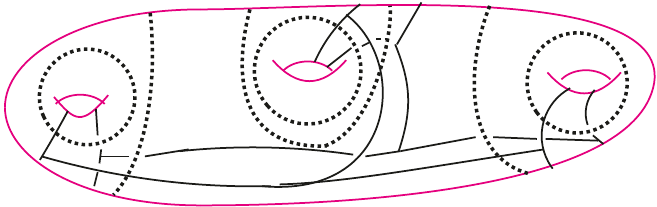
Figure 1 . A basis for a genus 3 surface. Three of the shown vacuum loops can be contracted to a trivial cycle after using repeatedly the sliding property with the remaining vacuum